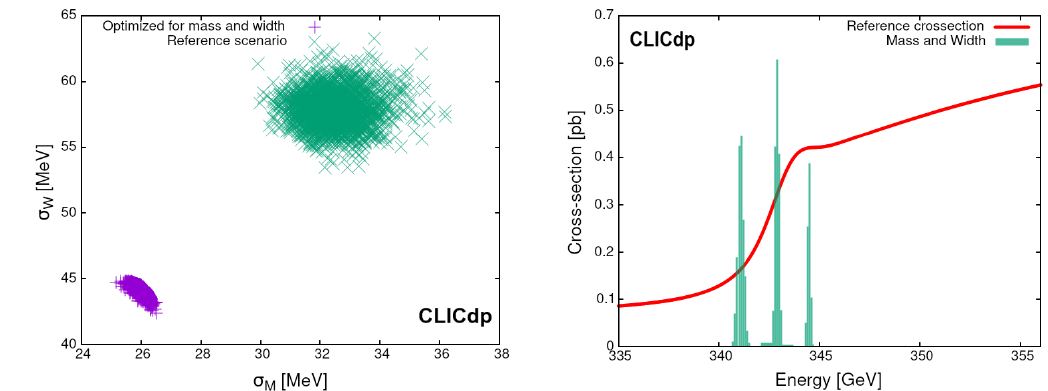
Figure 1: Left: fit uncertainty distribution in the first (green) and the last (blue) generation of the mass and width measurement optimisation procedure. Right: dis- tribution of the scan point energies for the last generation (green; vertical scale arbi- trary) compared with the reference cross section template (red). Figure reproduced from [ 2 ] .